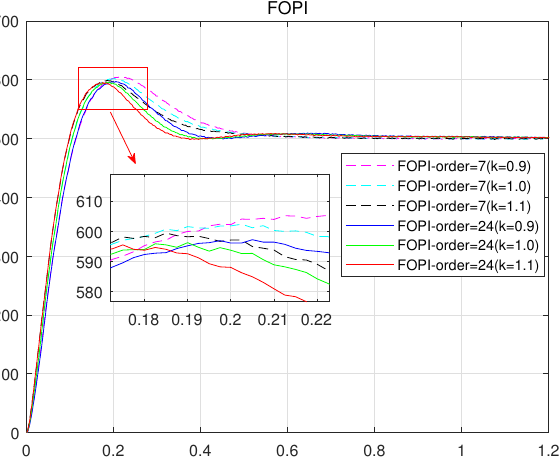
Figure 22. The speed responses of the PMSM system with different IOPI controller gains (Experiment).